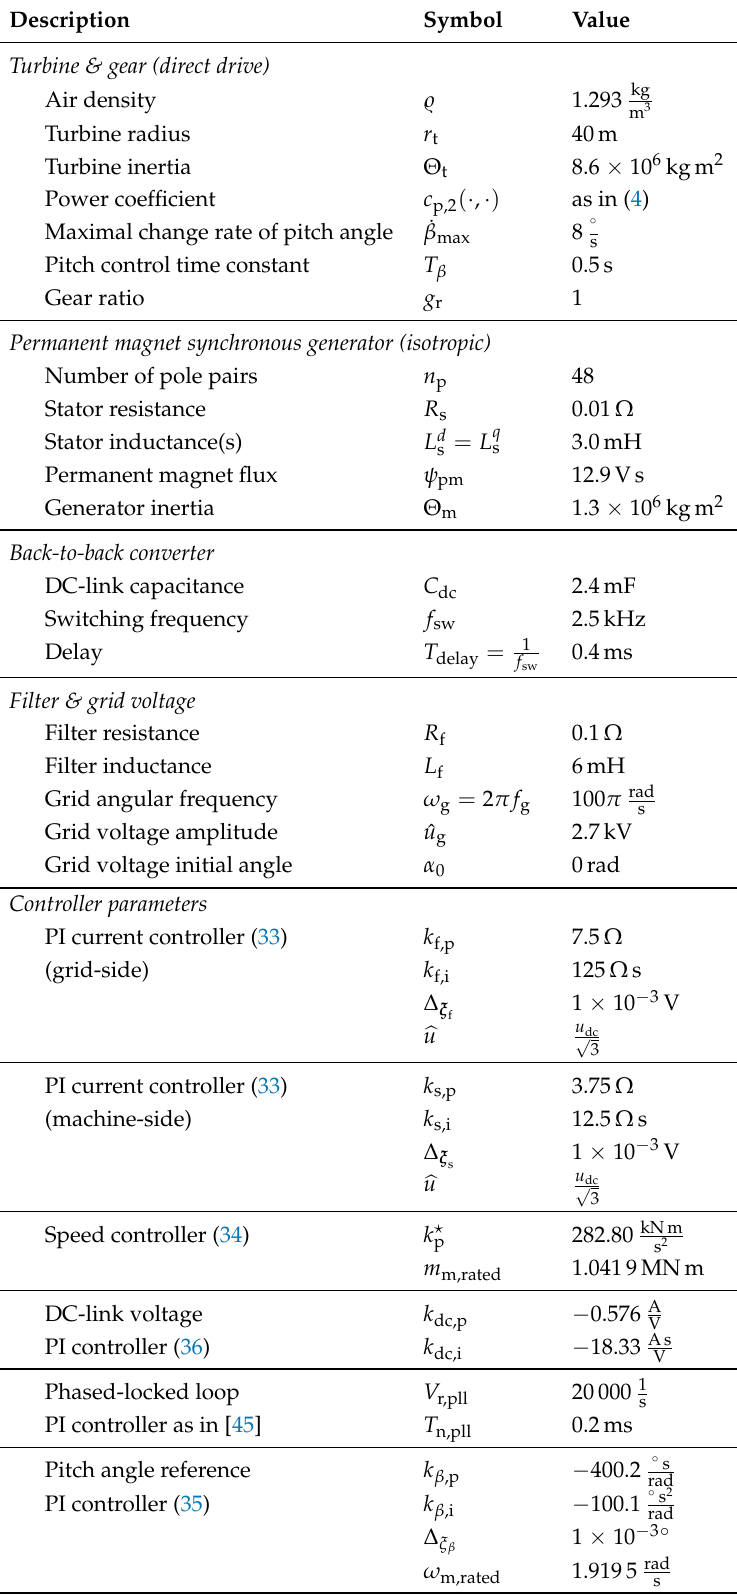
Table 1. List of system parameters used for